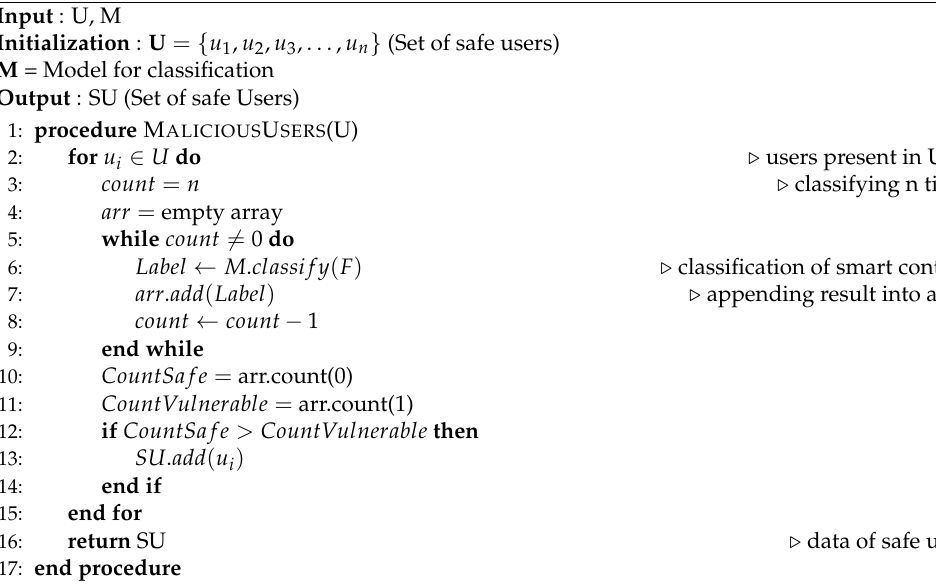
Figure 2. Sequence model for LSTM, GRU, and ANN. Algorithm 1 Algorithm for detecting malicious users